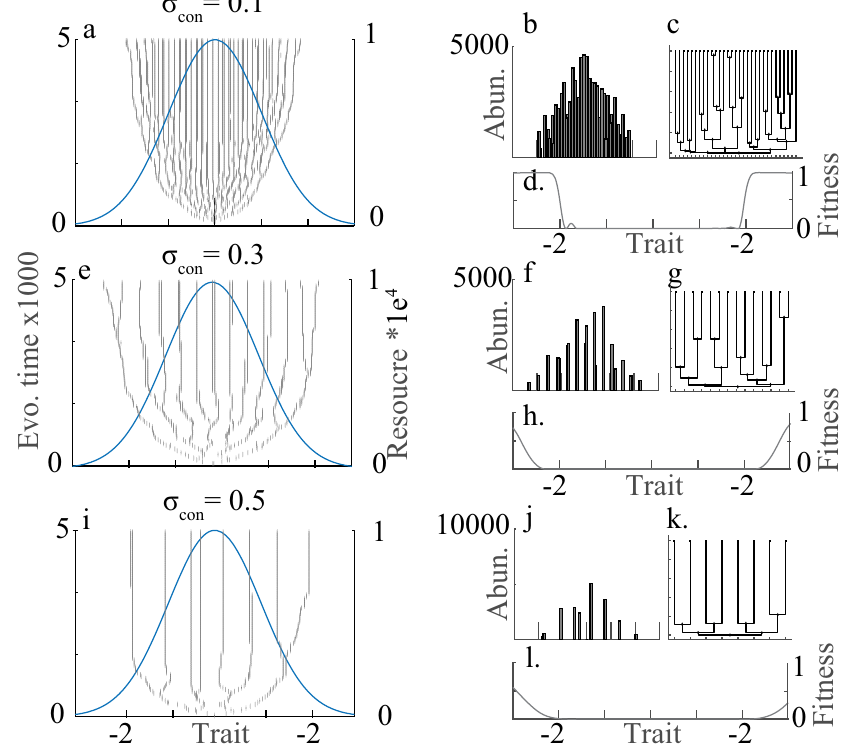
Figure 3. Adaptive radiations ( a , e and i ), trait distributions at evolutionary time 5000 ( b , f and j ), phylogeny ( c , g and k ) and fitness landscape at time 5000 ( d , h and l ) for simulations with species niche widths (σ con ) being set to 0.1 ( a – d ), 0.3 ( e – h ) and 0.5 ( i – l ). Each simulation was seeded with one monomorphic competitive population with a trait value equal to zero. Simulations were run for 5000 evolutionary time steps where each time step involves potential invasions of mutants and equilibrium population size computation. Community dynamics on both ecological (population dynamics) and evolutionary (macro-evolutionary dynamics) time scales are dictated by the consumer-resource and consumer-consumer trait matching as well as niche width and resource availability. Blue lines in a,e and i shows the resource distribution (second y-axis). Model parameters that were kept constant for the simulations were: K 0 = 10,000; σ K = 1; r = 1; µ = 0.01; σ µ = 0.02. Phylogenetic trees were constructed using data on the distance to the nearest common ancestor between the species at the 5000th simulation time step and the MATLAB function seqlinkage . Figure produced in MATLAB version R2019a.